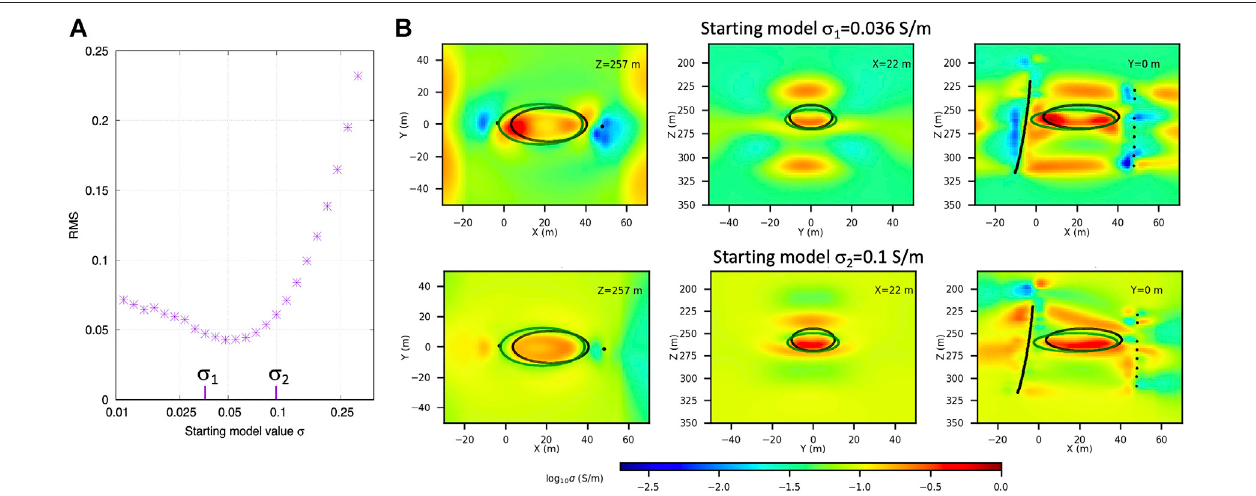
FIGURE 8 | (A) : Multiple inversion realizations for the conductive ellipsoidal anomaly (true model shown by Figure 5B , fi rst row) using a range of homogeneous starting model values. The RMS error quanti fi es the difference between the true model and each inversion result. (B) : Model reproductions exempli fi ed for two starting- model values, σ 1 (cid:2) 0 . 036 S/m and σ 2 (cid:2) 0 . 1